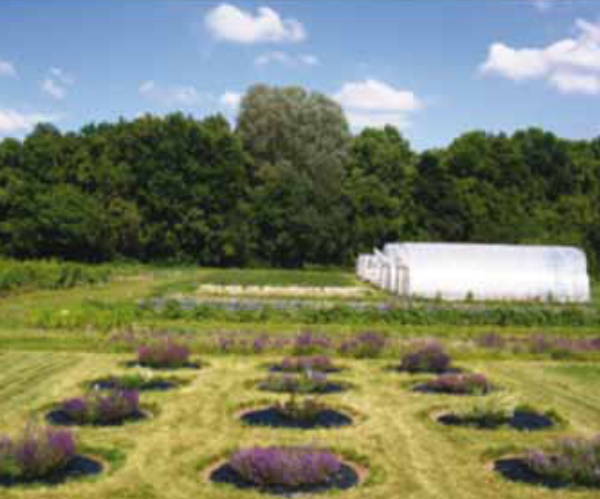
Figure 5: Creation of ex situ genebank for preservation of the biodiversity of domestic natural Salvia nemorosa